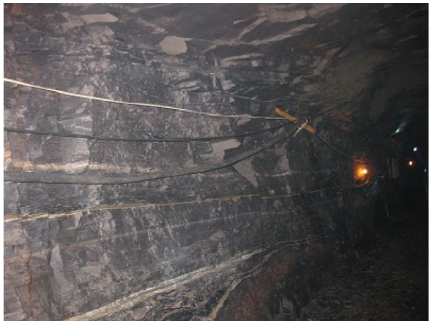
Figure 15: Construction scene of the tunnel.